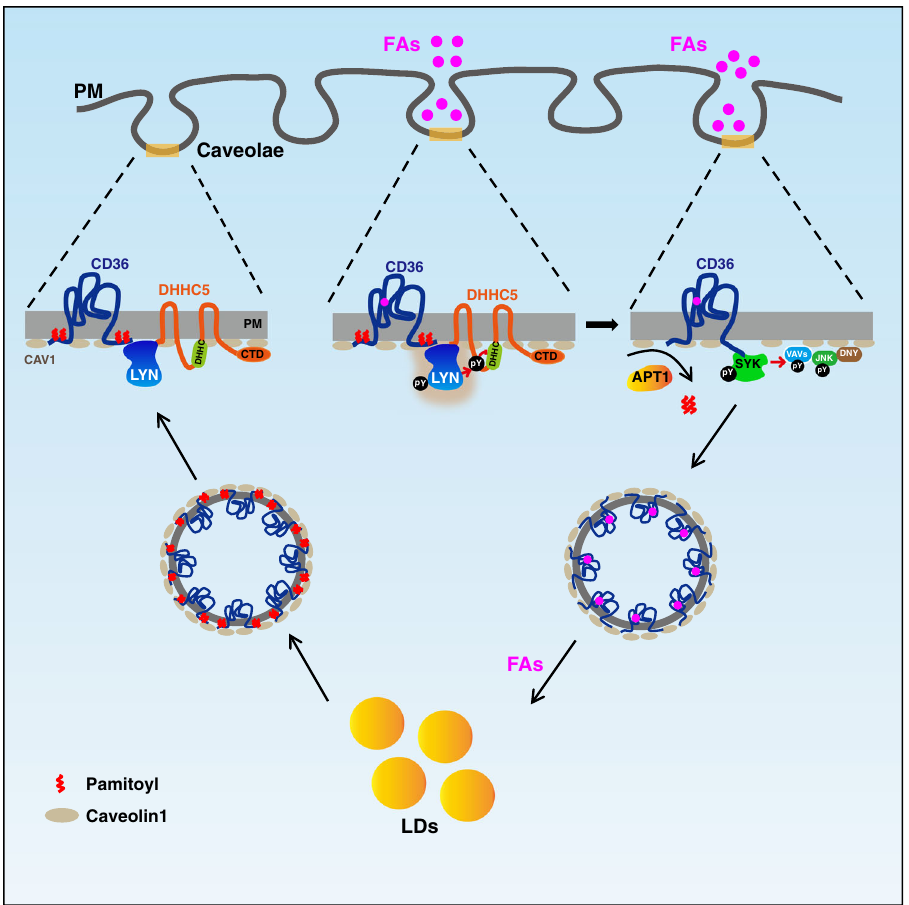
Fig. 8 A working model of FA uptake by CD36-mediated caveolar endocytosis. The plasma membrane of adipocytes is enriched with caveolaes. In a caveolae, CD36 is in the palmitoylated form and its FA binding cavity is on the outer layer, whereas CAV1 is on the inner layer. When FAs bind to CD36, a SRC kinase LYN gets activated, and it phosphorylates DHHC5 at Tyr91 and inactivates DHHC5, resulting in the subsequent depalmitoylation of CD36 by the depalmitoylase APT1. The depalmitoylated CD36 then recruits SYK to phosphorylate VAV and JNK, thereby initiating CD36-mediated caveolar endocytosis. The endocytosed vesicles deliver FAs to lipid droplets for storage. After that, CD36 gets re-palmitoylated and recycled to the plasma membrane for another round of